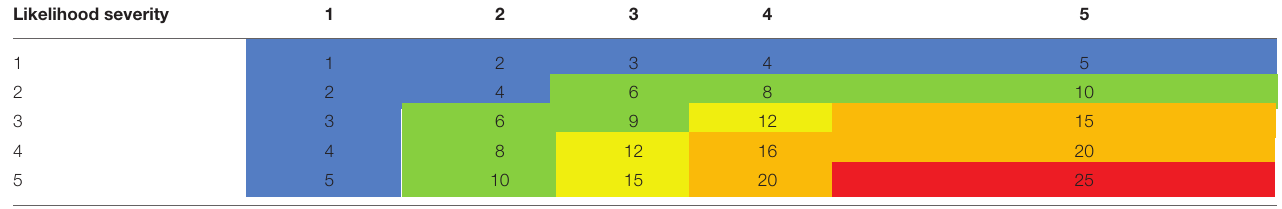
TABLE 1 | Establishing a laboratory hazard and process matrix-based risk system with standard linear scaling (values 1–5) to determine the risk score. Likelihood severity